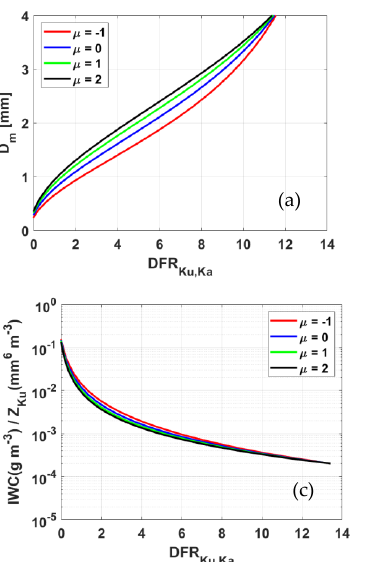
Figure 2. The dual-frequency ratios DFR versus D m ( a ), N w /Z Ku ( b ), IWC/Z Ku ( c ), and S/Z Ku ( d ) as a function of DFR when the densities of the aggregate are 0.06 g cm − 3 (red), 0.10 g cm − 3 (blue), 0.20 g cm − 3 (green), and 0.30 g cm − 3 (black); note that the elevation of radar is 0° and 𝜇 = 0.